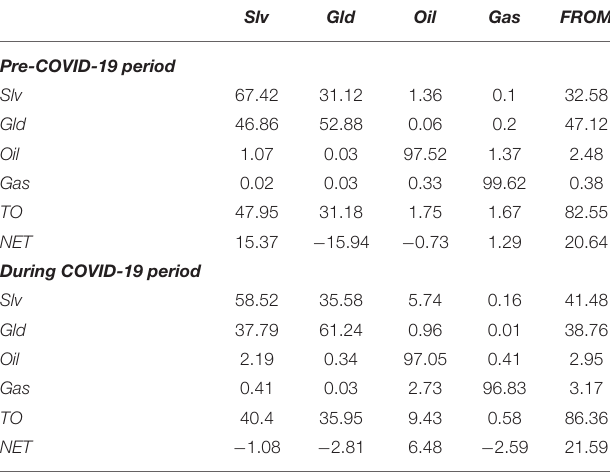
TABLE 4 | The volatility spillover of commodity price compound return sequences. Slv Gld